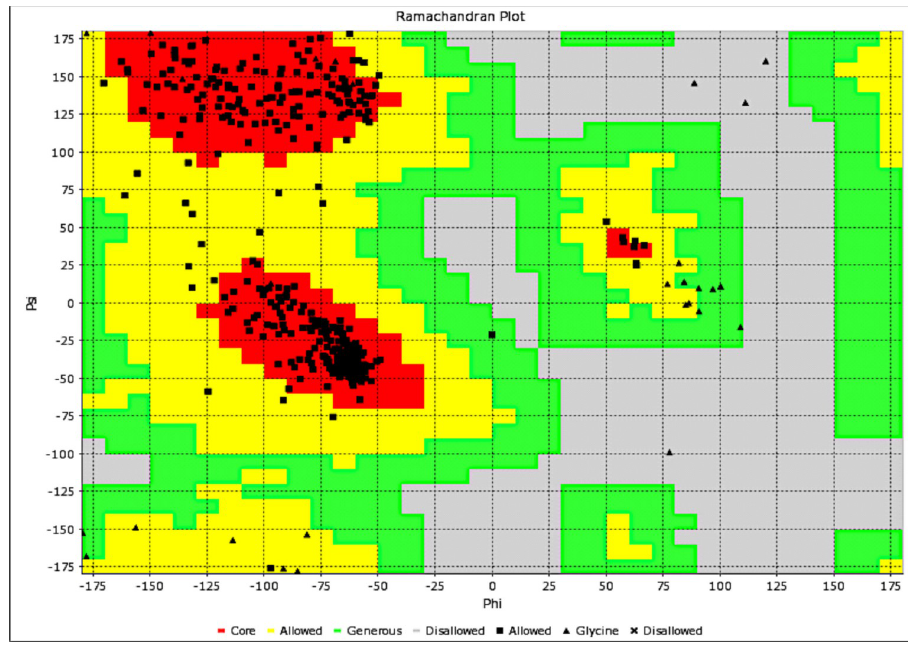
Fig 2. Ramachandran plot of modeled